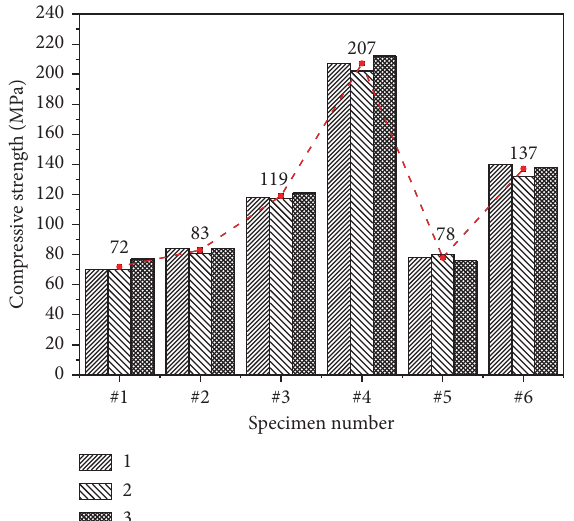
Figure 10: Compressive strength of spherical hinge of each set. The red-dotted line in the figure represents the average compressive strength of each set of specimens.